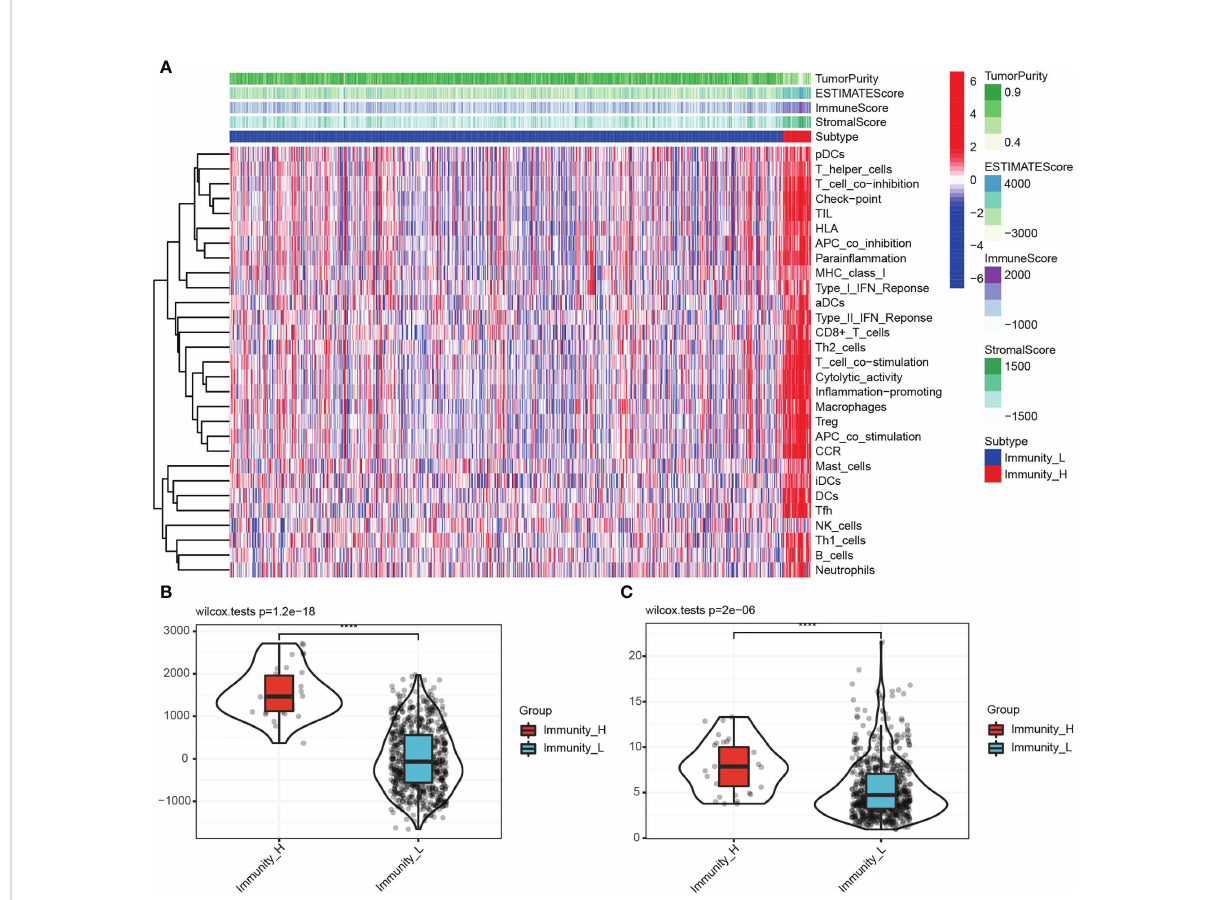
FIGURE 1 (A) Immune cell score, stromal cell score, combined scores of immune and stromal cells, and tumor purity in the high- and low-immunity groups. (B) The relationships between the immune score and different immunity groups. (C) The differences in TP53I13 expression in the high- and low-immunity